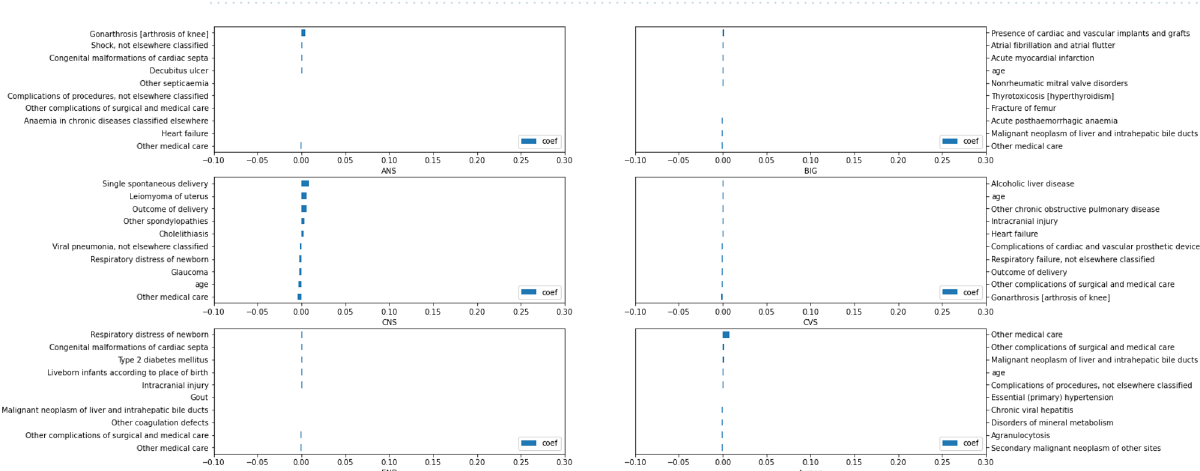
Figure 3. HAD type classification: Feature importance in OPD data set.